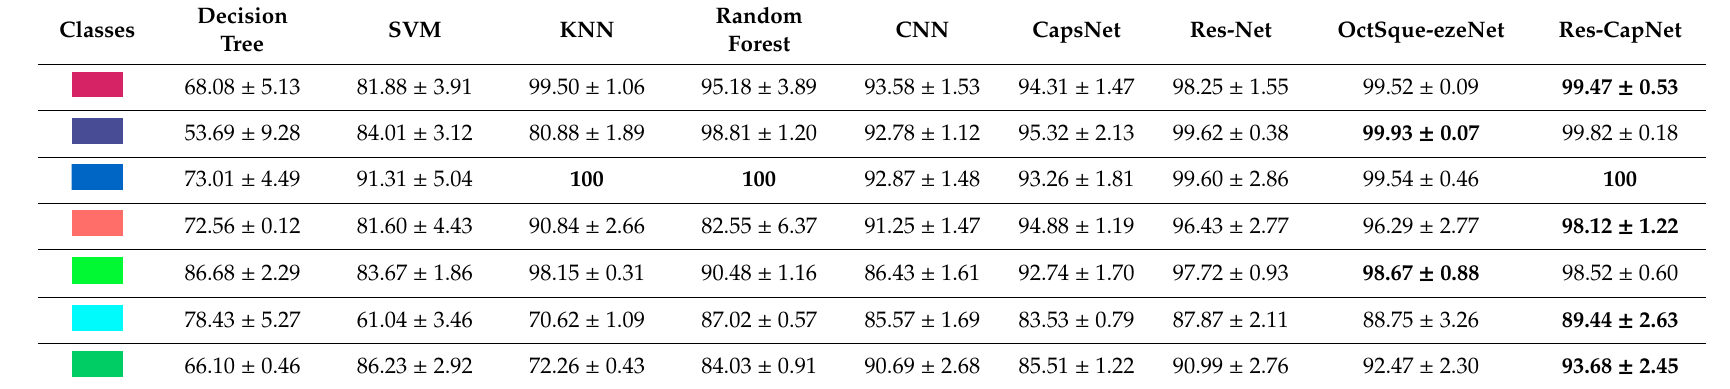
Table 6. Classification results of each class for 700 samples on Bayview Park data set.